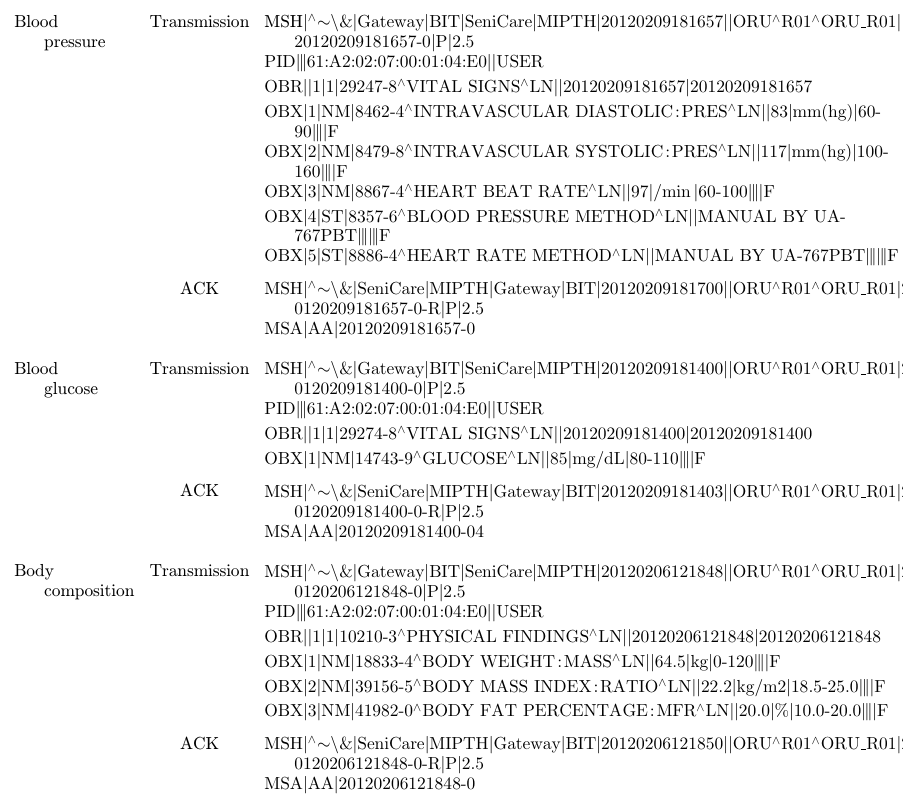
Table 2. HL7 ORU-R01 messages for transmission of